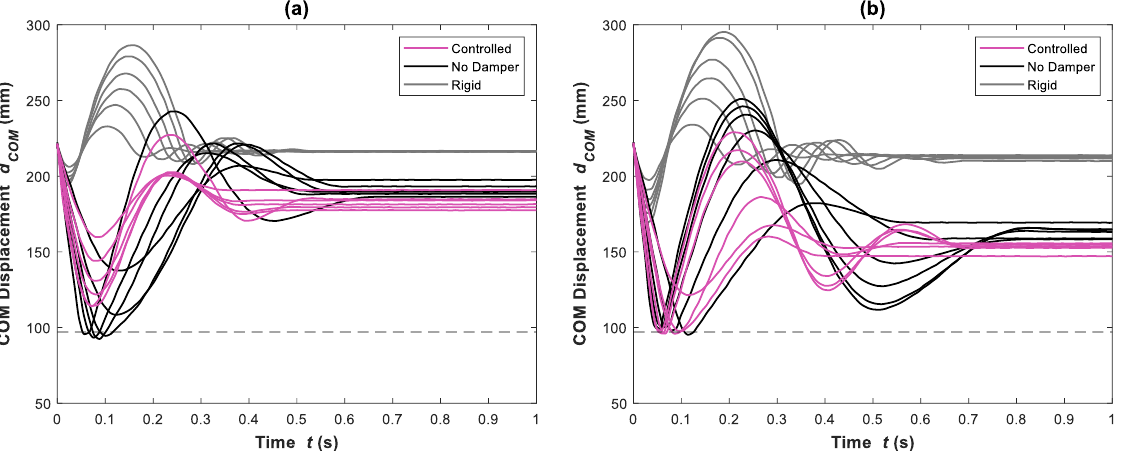
Figure 13. Controlled COM displacement for impact tests at all drop heights with total masses of ( a ) 2.65 kg and ( b ) 4.60 kg.